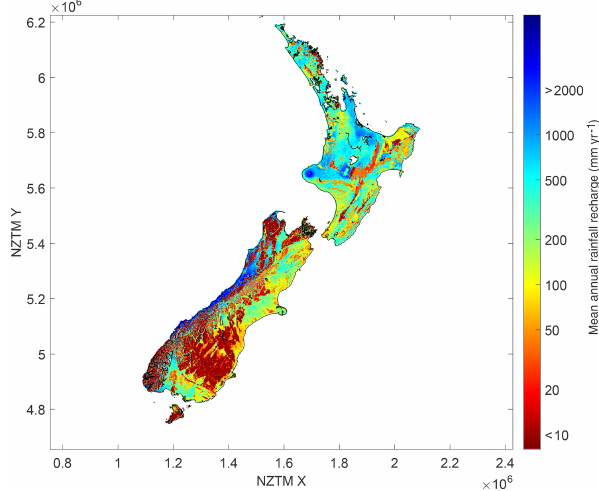
Figure 2. Mean annual rainfall recharge in New Zealand (2000– 2014; Westerhoff et al.,